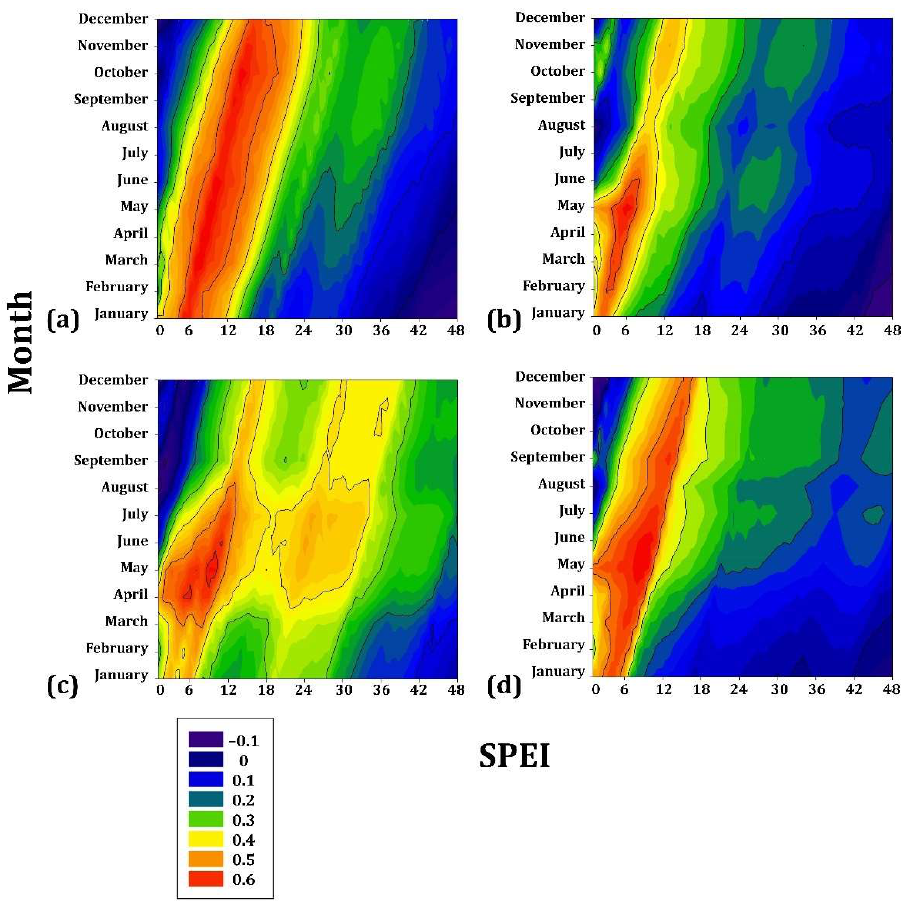
Figure 5. Drought–growth associations calculated for four Mexican conifer species (1901–3000 m asl) by relating the SPEI drought index to the residual growth–ring width chronologies. The SPEI was calculated in scales of 1 to 48 months ( x axes) from JAN to DEC in the current year of growth ( y axes). ( a ) Pinus engelmannii ; ( b ) Pinus maximartinezii ; ( c ) Pinus patula ; ( d ) Pinus johannis. The Pearson correlation coefficients (r) are indicated using color scales.